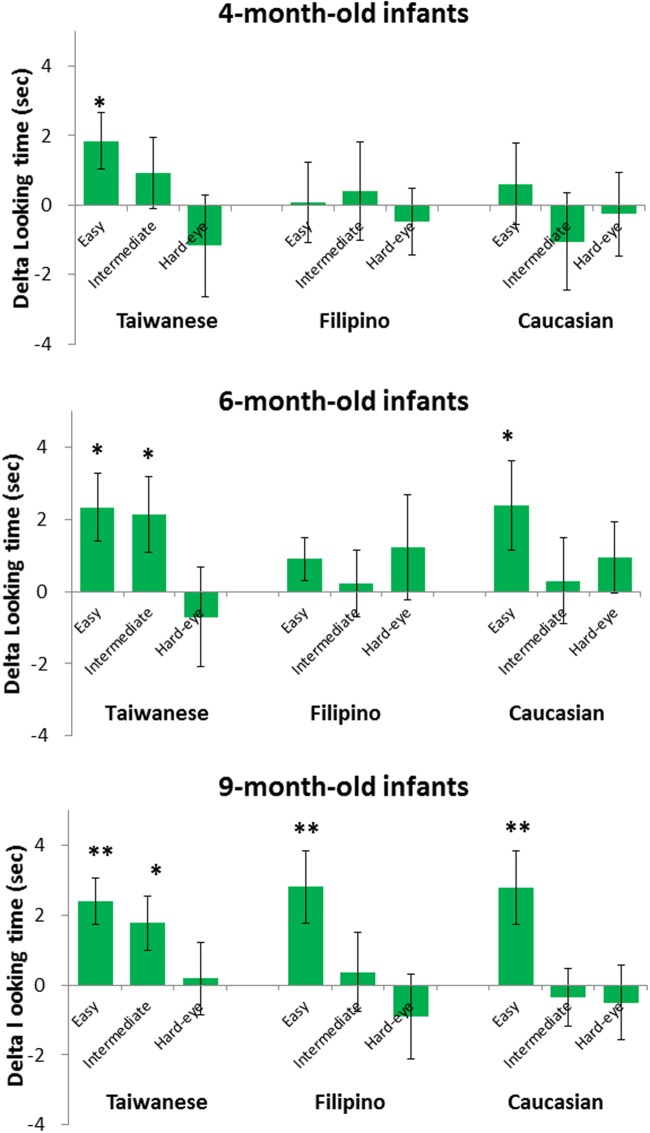
The delta looking time results for the 4-month-old (top graph), 6-month-old (middle graph), and 9-month-old (bottom graph) infants. The group mean delta looking times for each difficulty conditions in each ethnicity block are shown in the graph. The abscissa represents the “change identity”(easy), “change eyes”(intermediate), and “widen eye spacing”(hard-eye) conditions for the Taiwanese, Filipino, and Caucasian faces, while the ordinate depicts the group means of the delta looking time. The error bars represent the standard errors (±SE) of the group means. Level of significance: ∗p < 0.05; ∗∗p < 0.01; ∗∗∗p < 0.001.